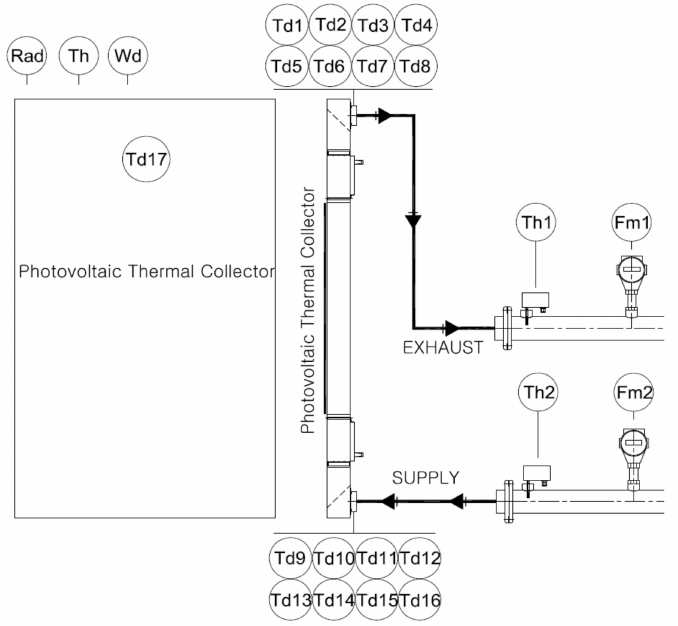
Figure 3. Location of measurement sensors for the